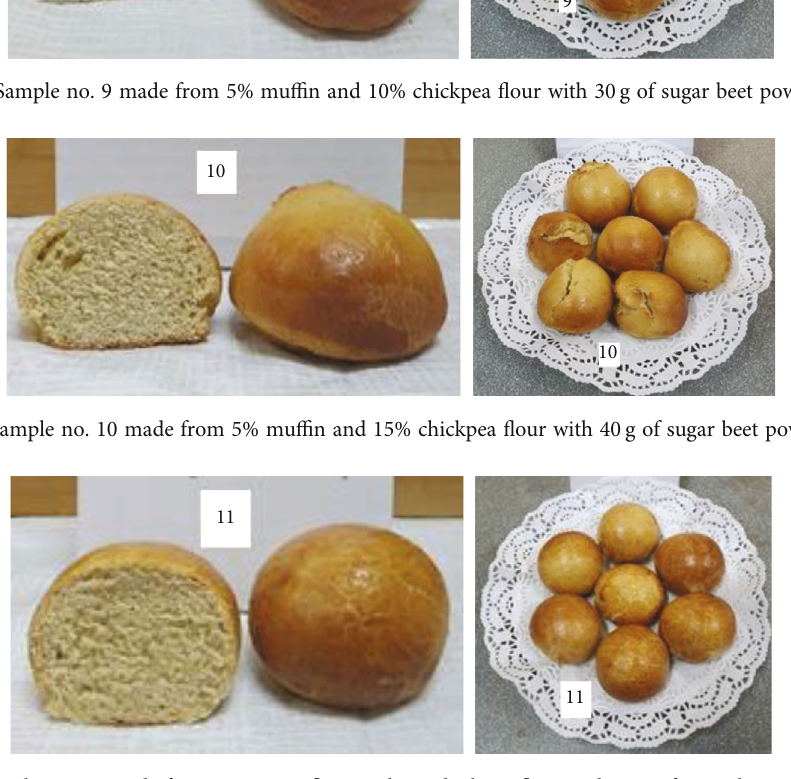
Figure 12: Sample no. 11 made from 5% mung fl our and 5% chickpea fl our with 40 g of sugar beet powder added. Table 7: Physical and chemical indicators of various bun